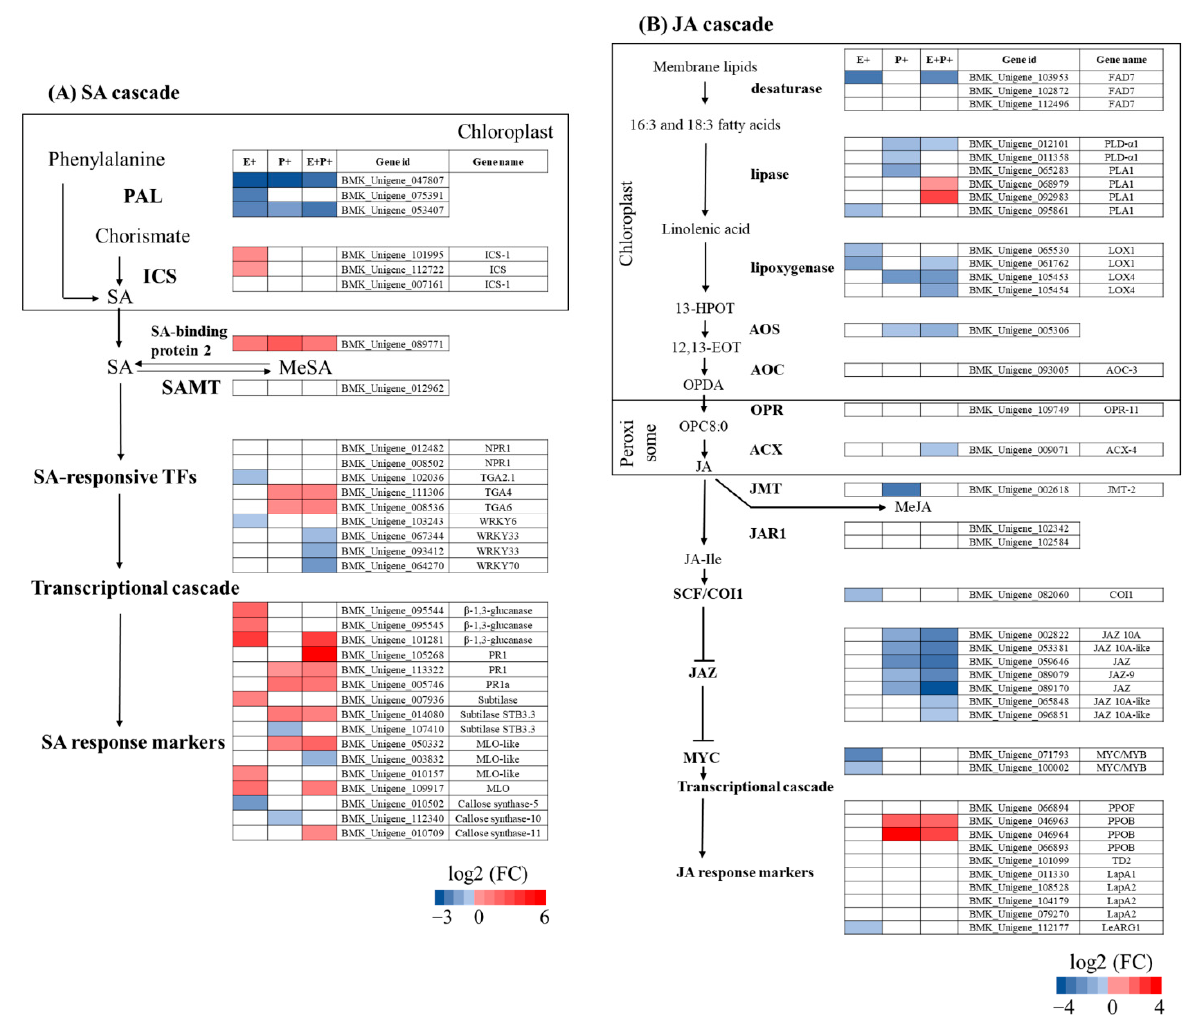
Figure 5. Changes in expression levels of plant genes associated with the salicylic acid (SA, panel A ) and jasmonic acid (JA, panel B ) signalling pathways given the presence of the fungal endophyte Epichloë gansuensis (E+), the fungal pathogen Blumeria graminis (P+) and both fungi (E+P+) on Achnatherum inebrians plants. The gene expression levels were measured at four weeks after the pathogen inoculation of plants. Proteins and enzymes are shown in bold. Arrows indicate positive regulation and truncated connectors indicate the opposite. Abbreviations: PAL, phenylalanine ammonia lyase; ICS, isochorismate synthase; MeSA, methyl salicylate; SAMT, salicylate-O-methyl transferase; NPR1, nonexpressor of PR genes 1; TGA, TGACG sequence-specific binding protein; WRKY, (T)TGAC(C/T) sequence-specific binding protein; PR1, pathogenesis-related protein 1; FAD, omega-3 fatty acid desaturase; PLD, phospholipase D; PLA1, plastochron1; LOX, lipoxygenase; 13-HPOT, 13-hydroperoxyoctadeca-9,11,15-trienoic acid; AOS, allene oxide synthase; 12,13-EOT, 12,13- epoxyoctadeca-9,11,15-trienoic acid; AOC, allene oxide cyclase; OPDA, 12-oxo-phytodienoic acid; OPR, oxophytodienoic acid reductase; OPC8:0, 3-oxo-2-(cis-2’-pentenyl)cyclopentane-1-octanoic acid; ACX, acyl coenzyme-A oxidase; OPC, OPC- 8:0 CoA ligase1; JMT, jasmonic acid carboxyl methyltransferase; MeJA, methyl jasmonate; JAR1, jasmonoyl–L-amino acid synthetase JAR1; JA-Ile, JA-isoleucine conjugate; COI1, coronatine-insensitive protein 1; JAZ, jasmonate ZIM domain; MYC2, bHLH transcription factor; PPOF, polyphenol oxidase F, chloroplastic; PPOB, polyphenol oxidase E, chloroplastic-like; TD2, threonine dehydratase 2 biosynthetic, chloroplastic; LapA, leucine aminopeptidasee, chloroplastic; LeARG1, arginase 1. Red and blue colors on cells indicate significant differences in gene expression levels expressed as log2 fold changes (FC) ( n = 3). FC- and p -values of each gene are presented in Table